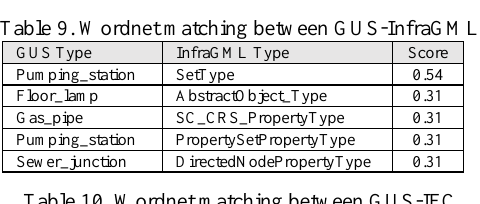
Table 7. GroupBy Type matching between GUS-IFC GUS Type